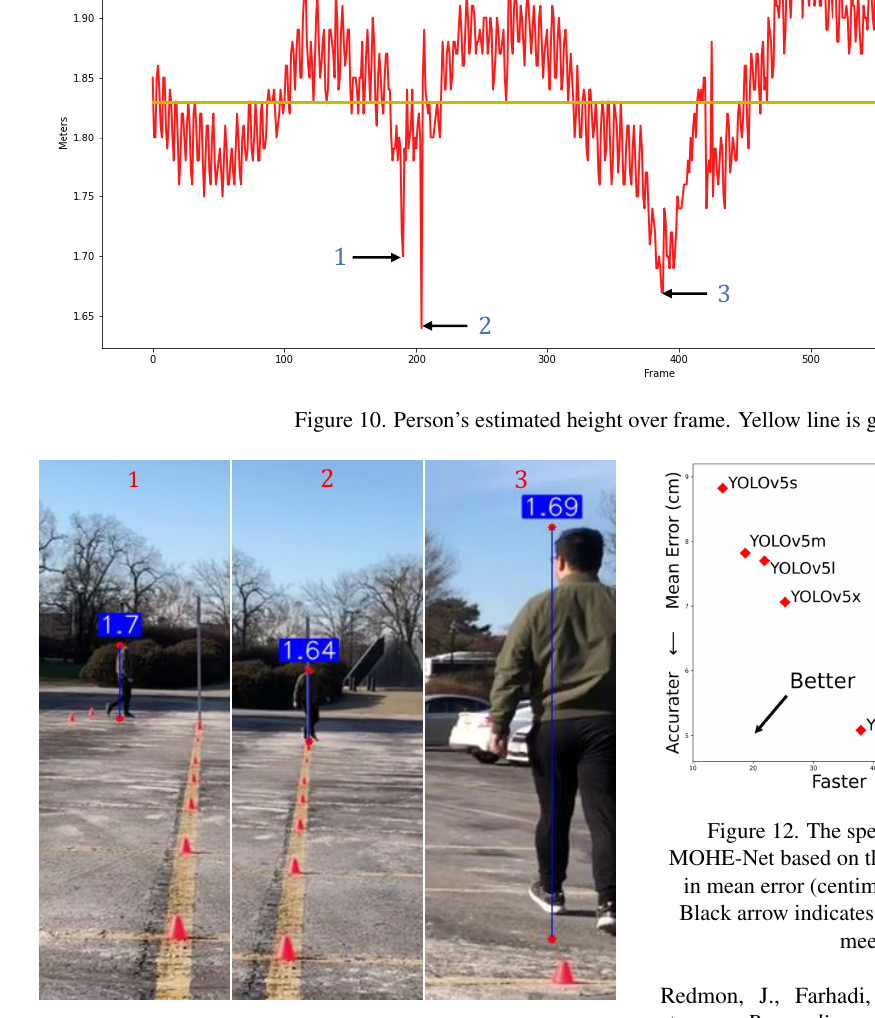
Figure 11. Three predictions scenes corresponding to the pointing out abnormal results in Fig. 10. Person’s appearance looks dark similar to the background in the first and second columns. Besides, person in column 2 was also occluded by a sign post. In third column, person is partially outside camera view, resulting in occlusion.